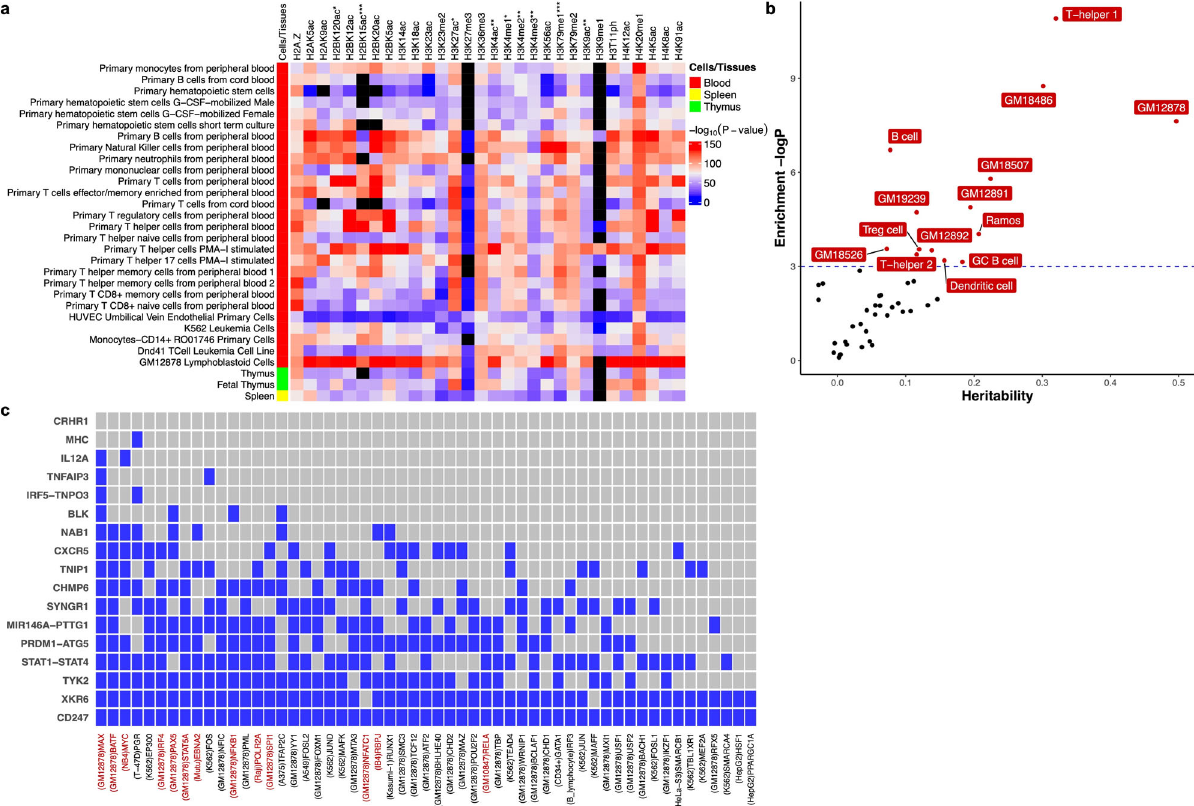
Fig. 4 Epigenetic and transcription factor enrichment analysis of Sjögren ’ s risk loci in speci fi c cell types and tissues. a Enrichment analysis of 30 histone marks in 127 different cell types and tissues from the Roadmap Epigenome Consortium Project was performed using GREGOR software. Heatmap displays the enrichment P -value for each histone mark plotted relative to speci fi c immune cell types from the blood (red), spleen (yellow), and thymus (green). Black boxes indicate missing data. Complete analysis of all 127 cell types and tissues from the Roadmap Epigenome Consortium Project are reported in Supplemental Fig. 8 and Supplemental Data 3. b Enrichment of heritability in cell type-speci fi c enhancers reported in the EnhancerAtlas2.0 database. Enrichment was calculated as partitioned heritability divided by the proportion of GWS Sjögren-SNPs that intersect with enhancer regions in each cell type. Cell types exhibiting signi fi cant GWS Sjögren-SNPs in enhancers are indicated in red. Blue dashed line is the threshold of signi fi cance after correction for multiple testing of P ≲ 0.05. c Enrichment of cell type-speci fi c transcription factor binding sites. Transcription factors are indicated by a blue box if at least one Bonferroni-corrected ( P ≲ 0.05) intersection between an indicated transcription factor and Sjögren-associated risk locus was detected. Red font indicates transcription factors that are also associated with the EBNA2 super enhancer. The cell type with the most signi fi cant interaction is listed in parentheses for each transcription